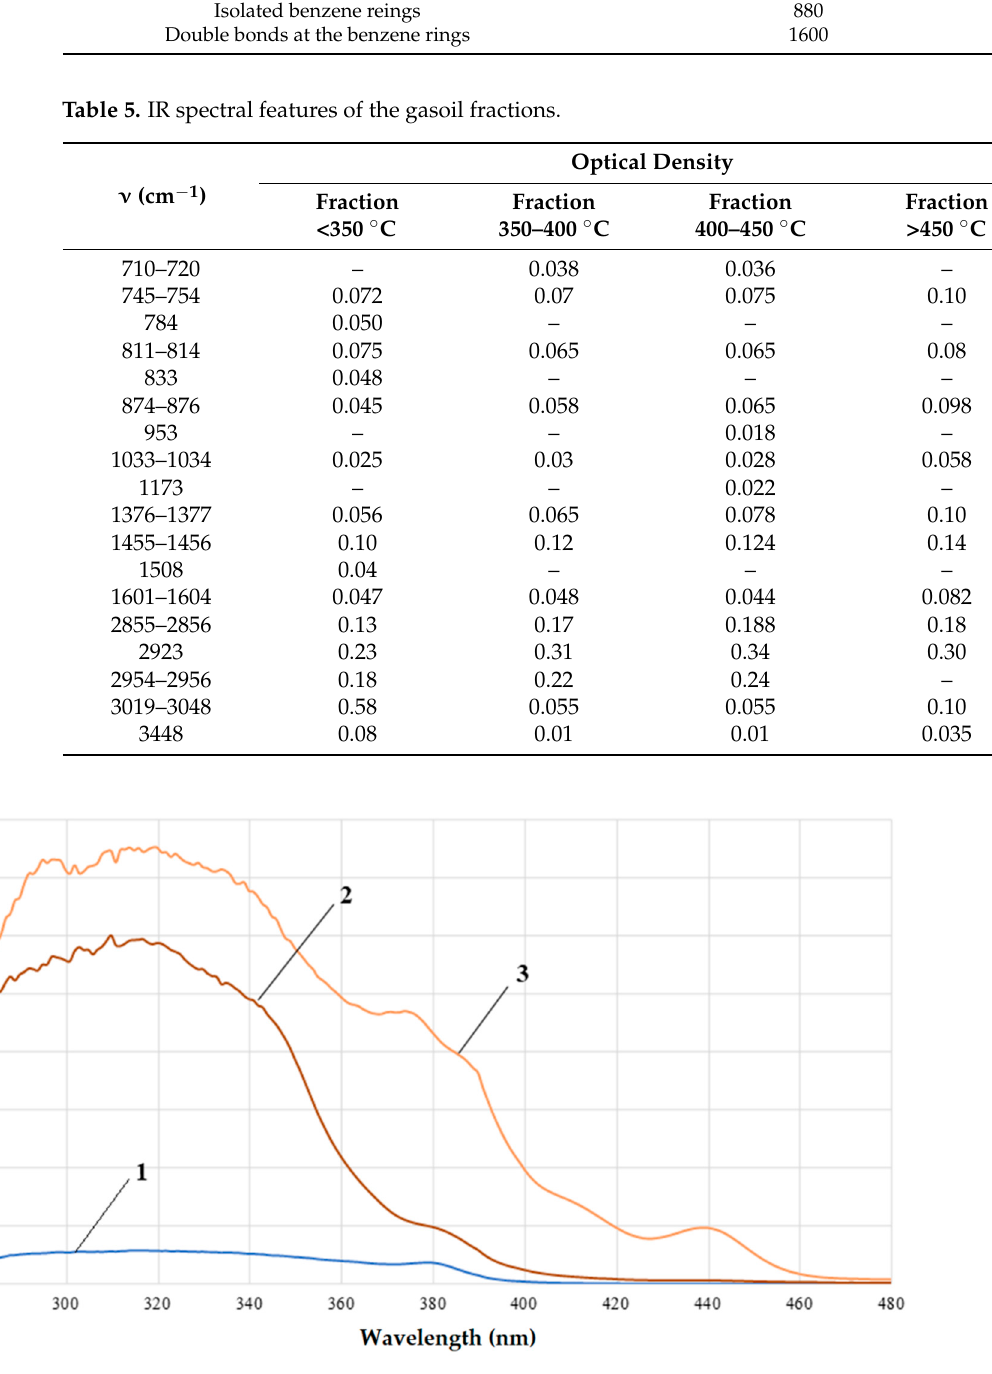
Figure 4. UV-vis spectra of the gasoil fractions: lower 350 ◦ C (1); fraction 350–400 ◦ C (2); and